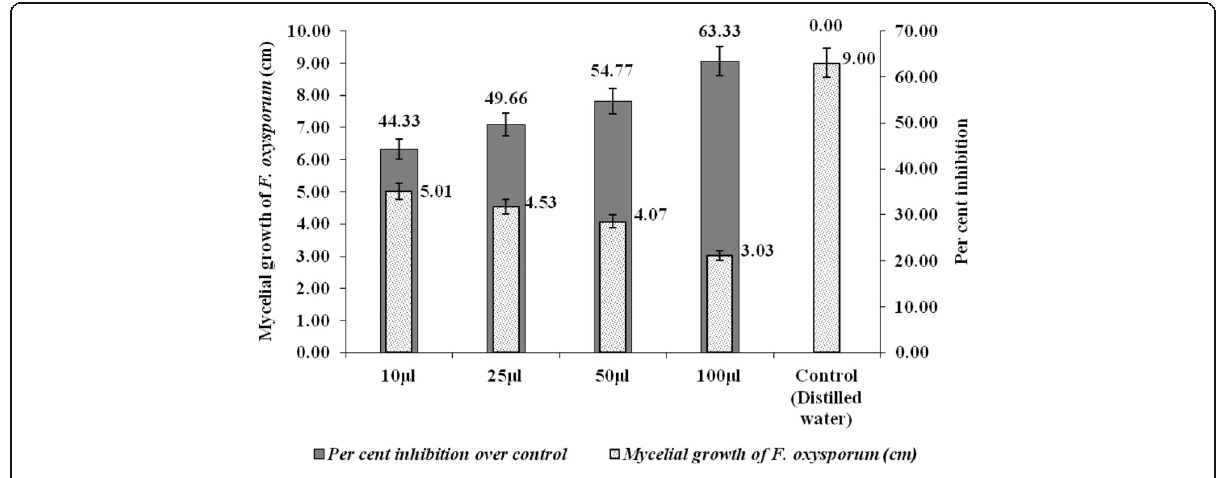
Fig. 4 Bioassay of crude antibiotic against F. oxysporum in vitro